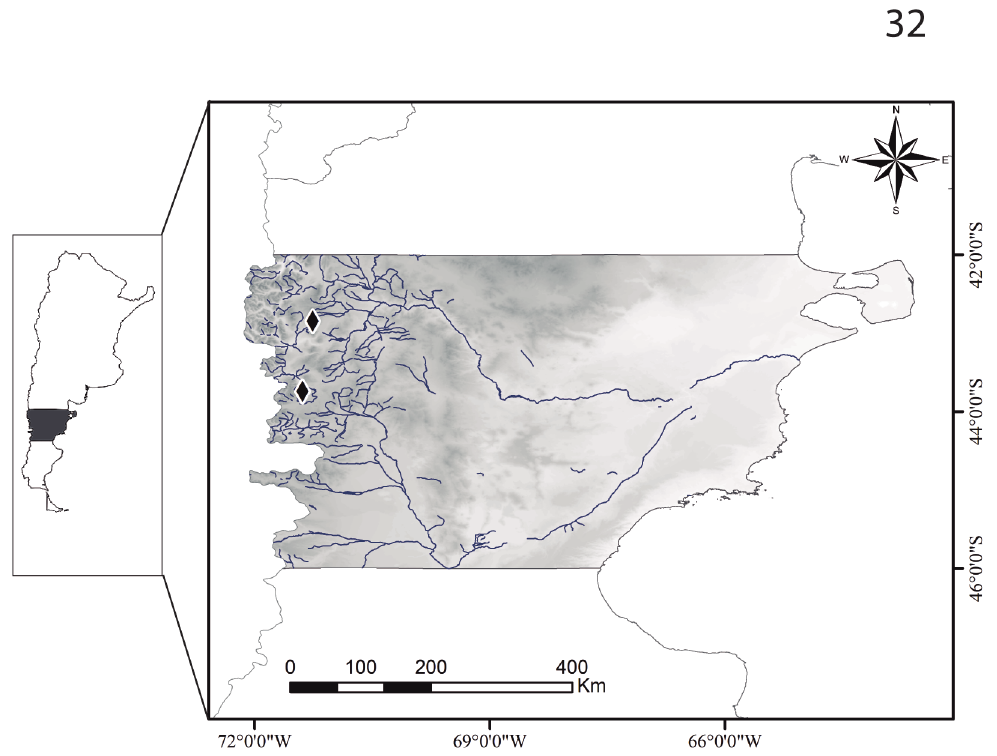
Figure 32 - Distribution map of Stethelmis shepardi sp.